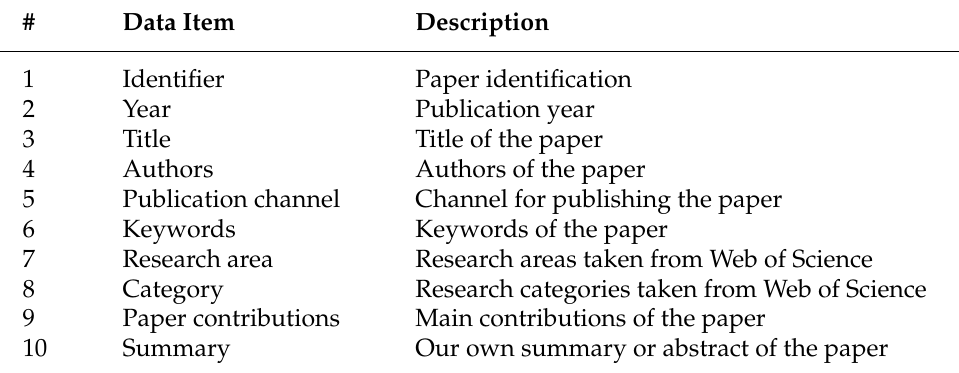
Table 3. Extracted data